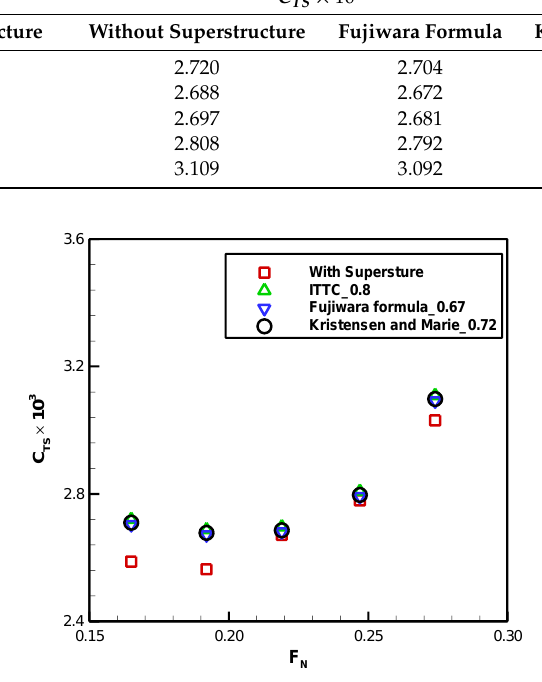
Figure 11. Comparison of total resistance coefficient by 𝐶 𝐷𝐴 . Table 10. The total resistance coefficient according to 𝐶 𝐷𝐴 .